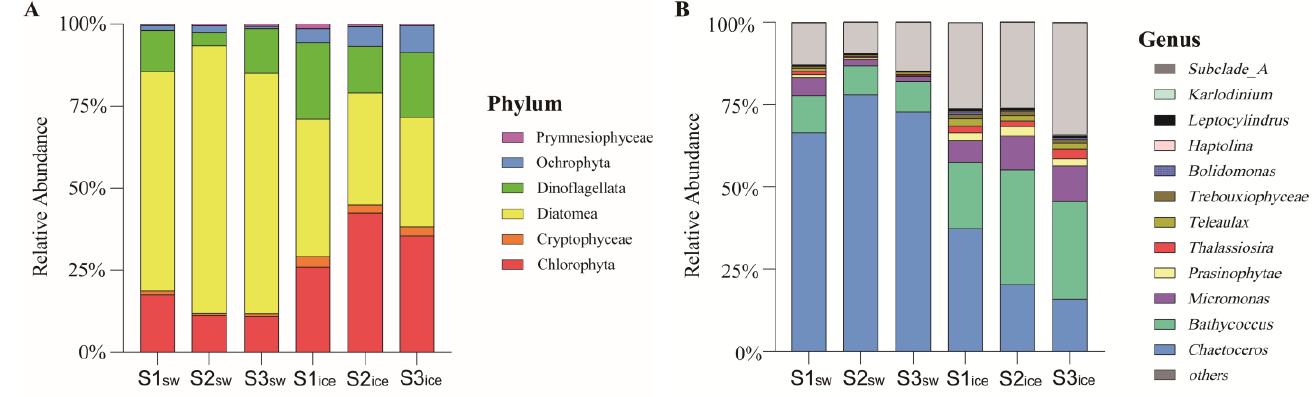
Figure 3. Relative abundance of the eukaryotic microalgal community in the seawater and in the sea ice at the phylum level ( A ) and genus level ( B